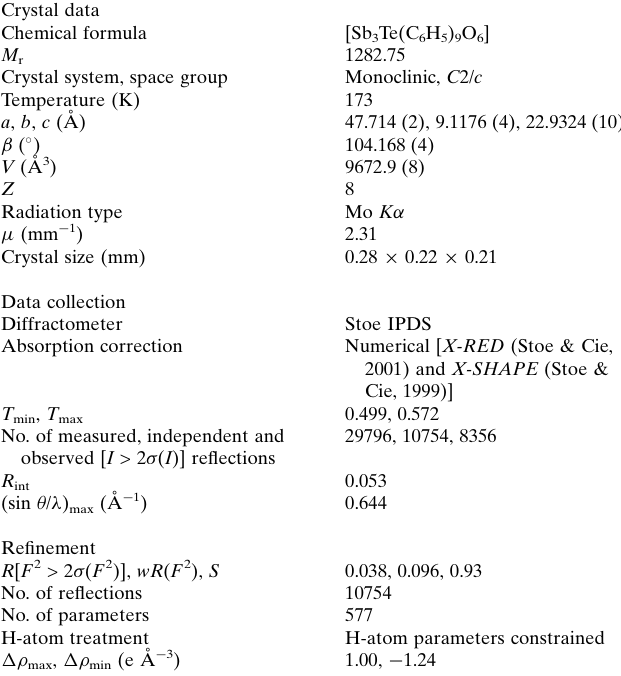
Table 3 Experimental details. Crystal data Chemical